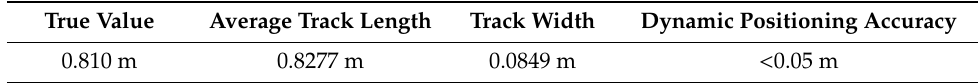
Table 2. Analysis of dynamic positioning measurement data when two base stations are 50 m